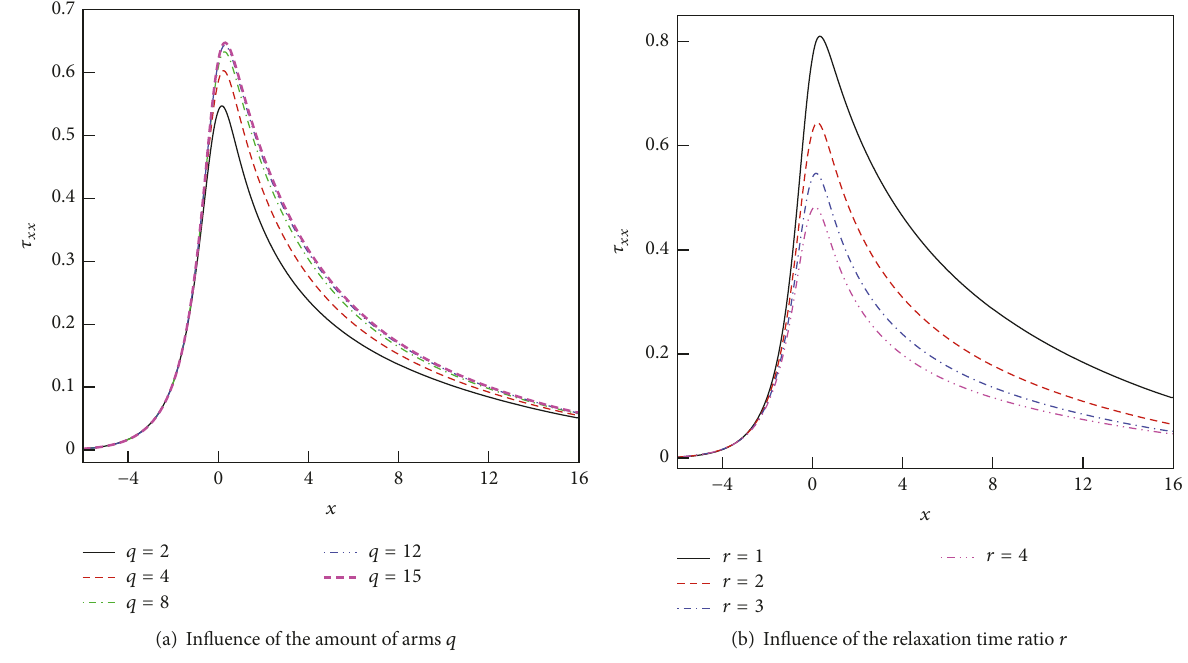
Figure 3: The influence of different parameters on 𝜏 𝑥𝑥 : (a) 𝑞 and (b) 𝑟 .